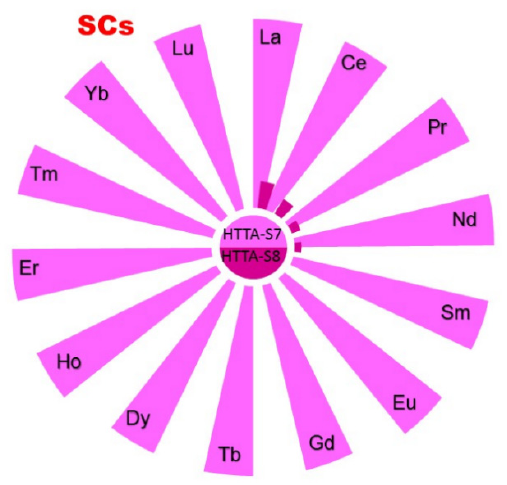
Figure 9. SC data visualization of the two solvent systems HTTA − S7 and HTTA − S8 with a Nightingale rose diagram.